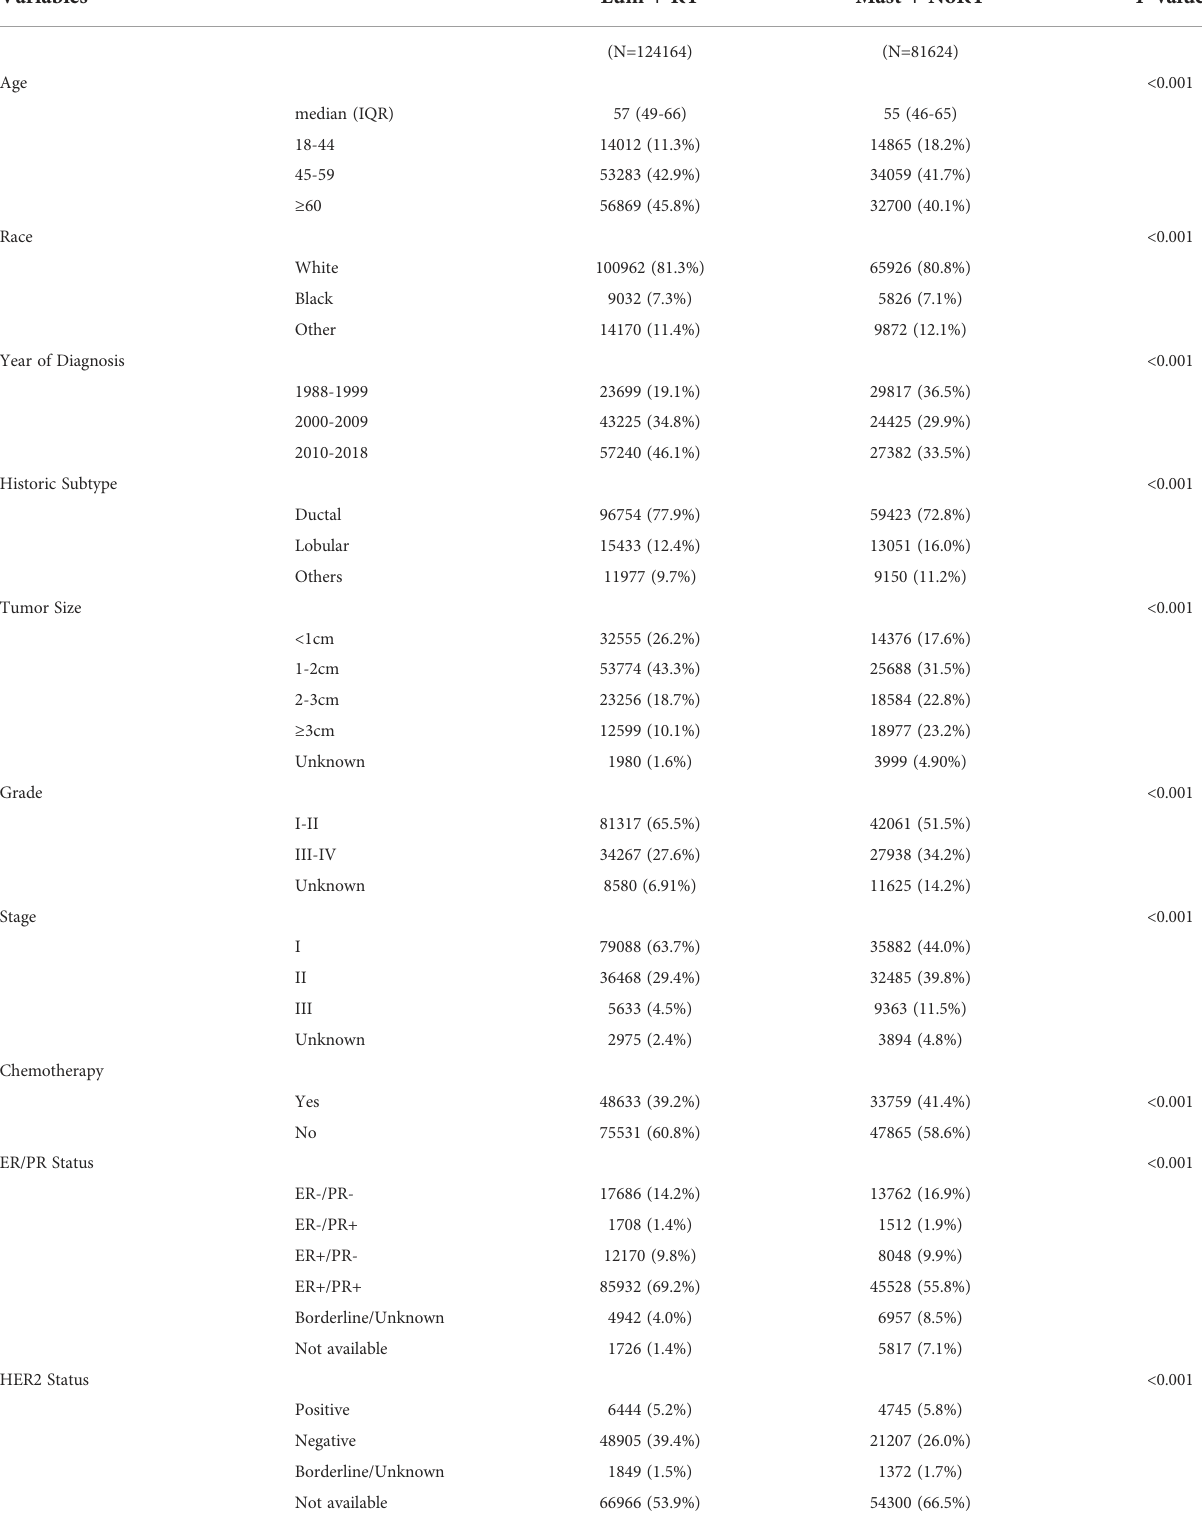
TABLE 1 Baseline characteristics of 205,788 female breast cancer patients by